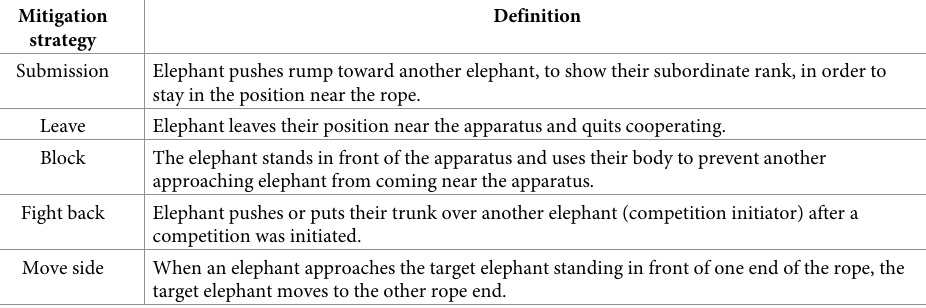
Table 2. Mitigation strategies developed by elephants during the experiment and their